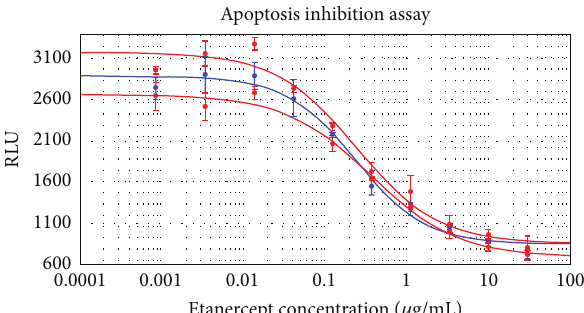
Figure 4: Dose-response curves of Infinitam (blue) and the reference product (red).